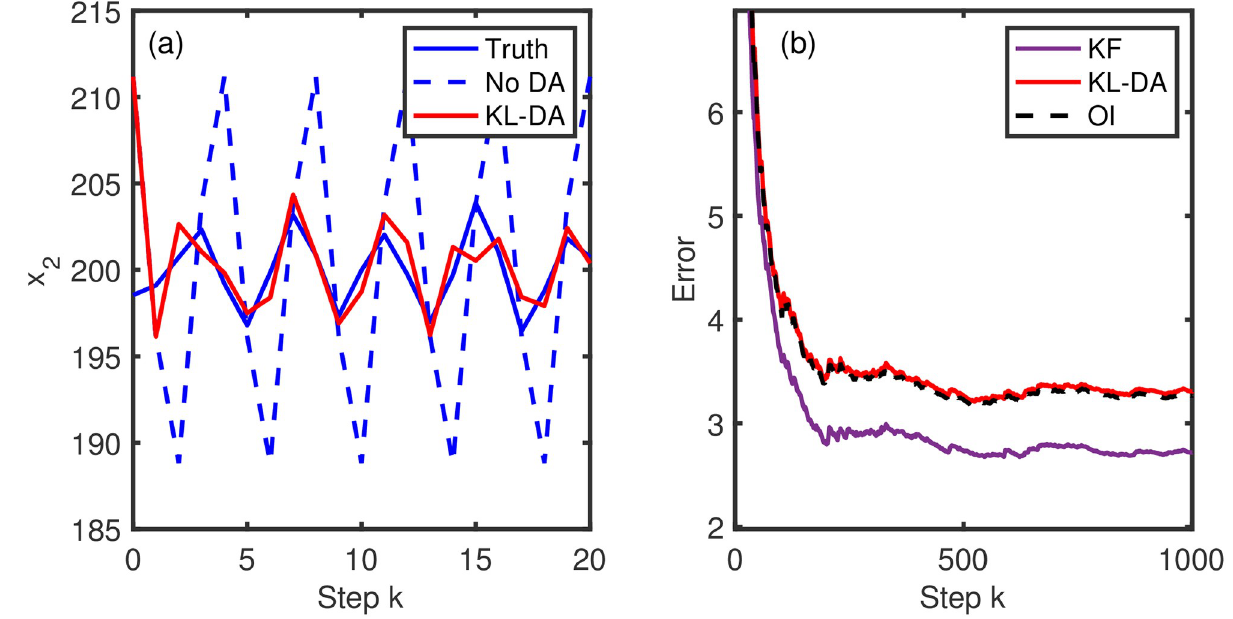
Fig 3. Experiment 1 results. The modelled solution (a) and running average root mean square error (b).